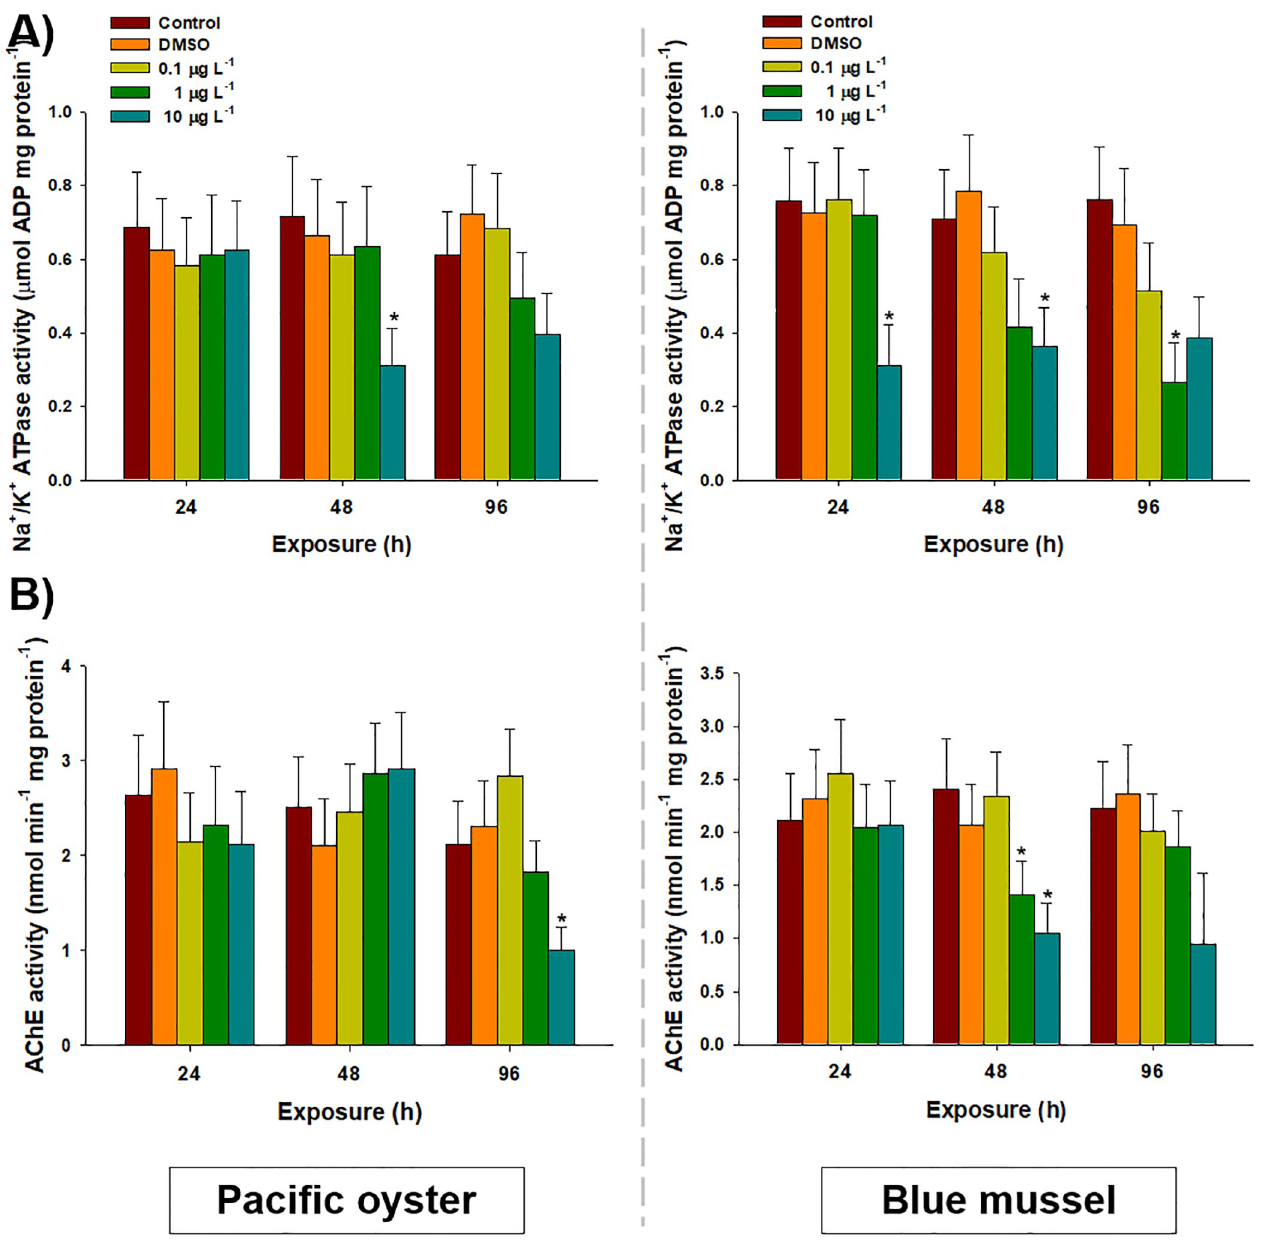
Fig 4. Effects of waterborne chlorothalonil on physiological parameters of marine bivalves. Effects of different concentrations of chlorothalonil (0.1, 1.0, and 10.0 μ g L -1 ) on (A) Na + /K + -ATPase and (B) acetylcholinesterase (AChE) levels in the gill tissues of Pacific oysters ( Crassostrea gigas) and blue mussels ( Mytilus edulis) over 96 h. Data are expressed as the mean ± standard deviation (S.D.). An asterisk ( � ) indicates significant differences compared to the control ( P < 0.05).